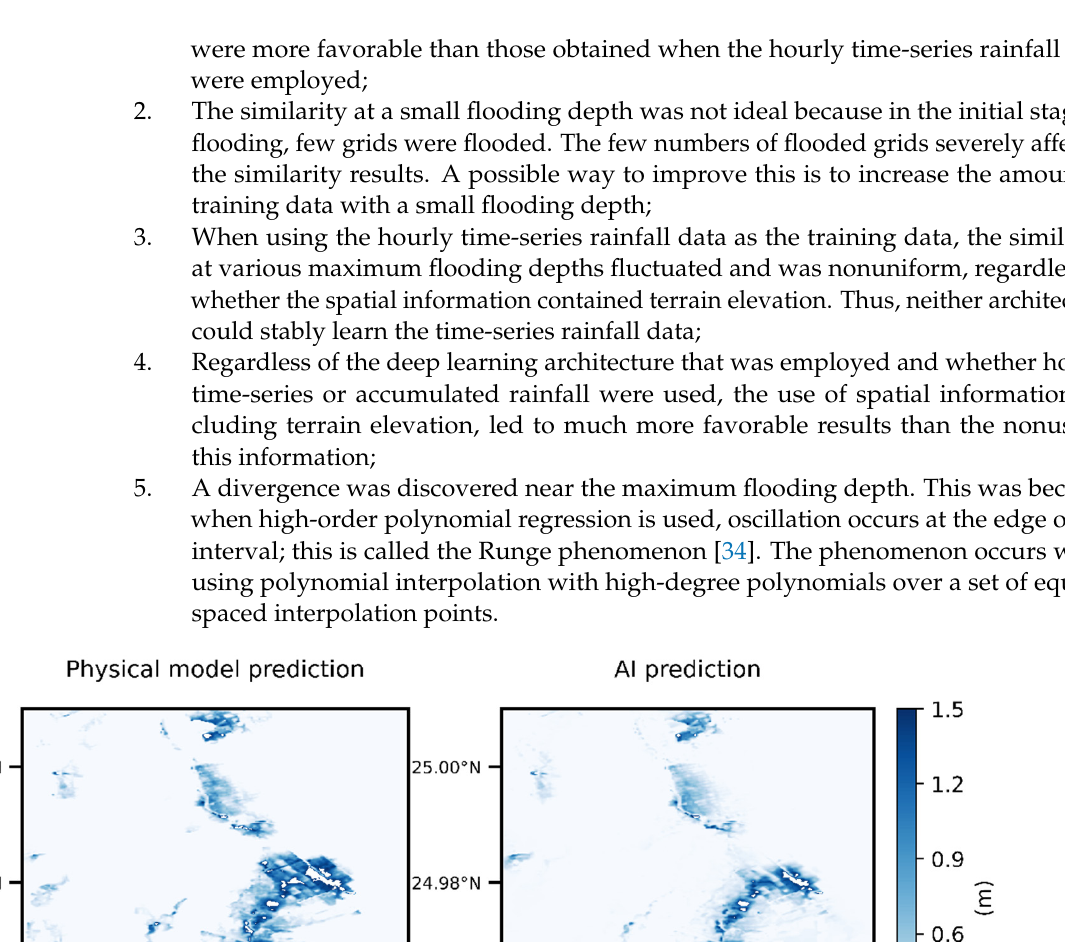
Figure 9. Convergence of the loss function for different models: ( a ) training data; and ( b ) validation data.